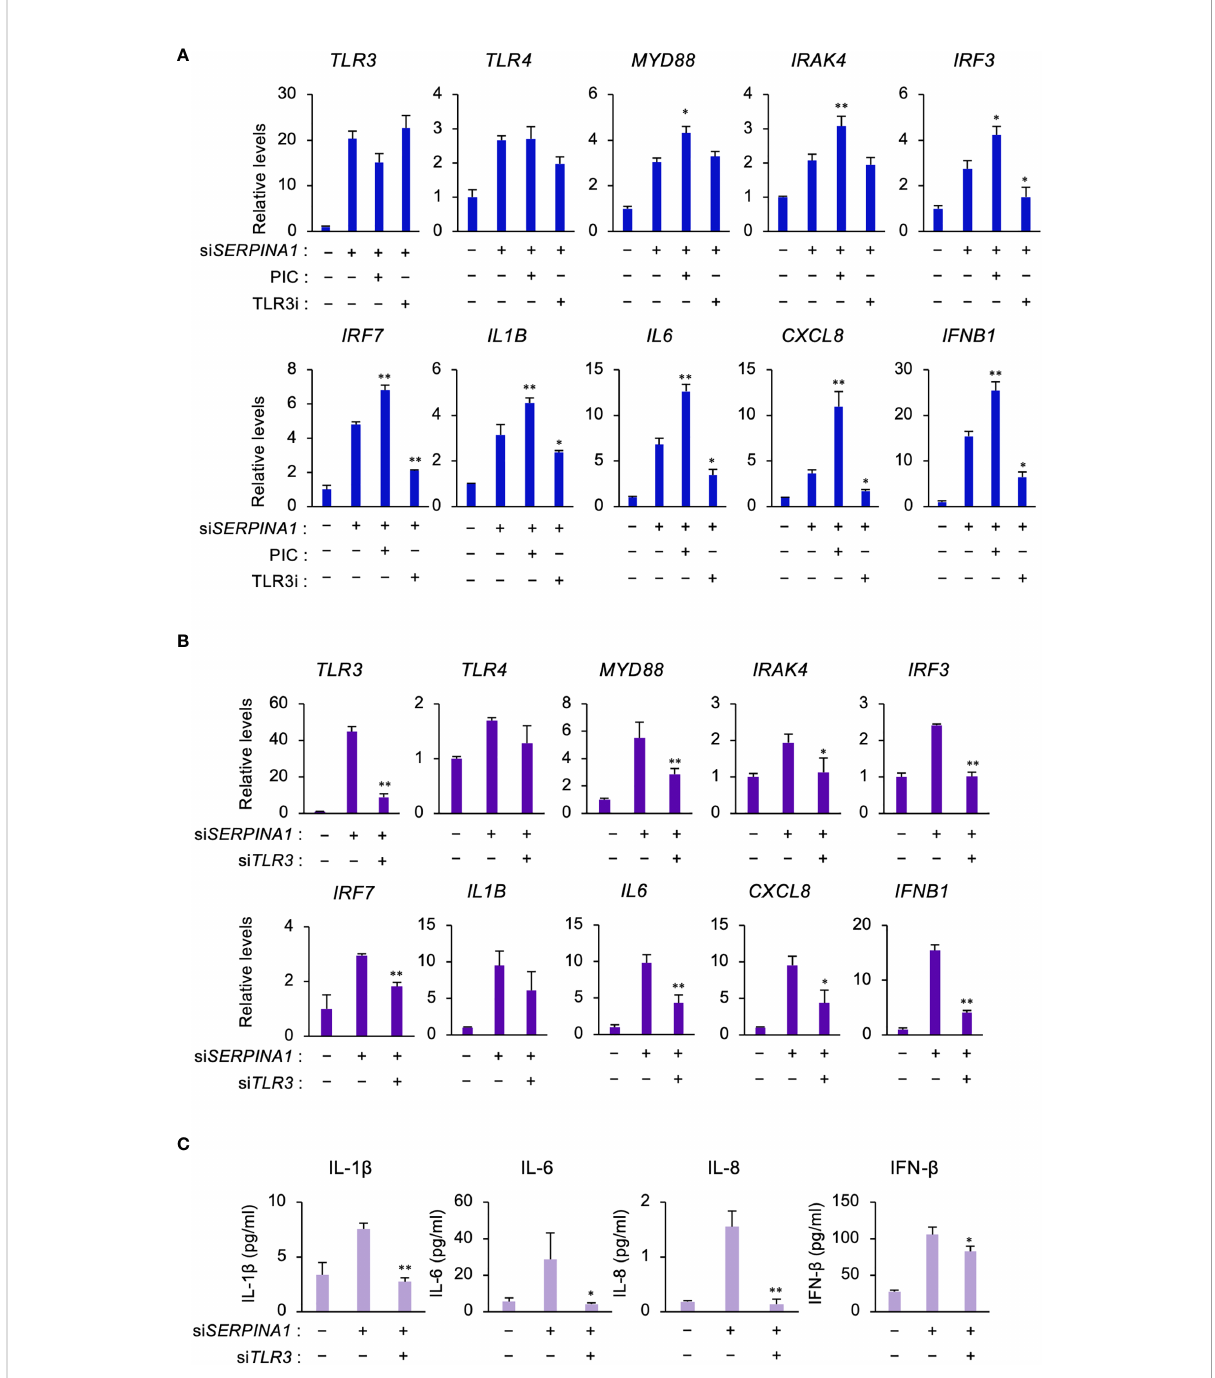
FIGURE 2 TLR3 upregulates expression of TLR- or in fl ammatory-related genes in ESCs. (A) Expression of TLR3 , TLR4, MYD88, IRAK4, IRF3, IRF7, IL1B, IL6 , CXCL8, and IFNB1 in primary ESCs pre-treated with PIC (10 m g/ml) or TLR3i (10 m M) and then transfected for 24 h with si SERPINA1 (n=3). GAPDH was used as the reference gene. Values represent the mean ± SEM of three independent experiments. * P <0.05, ** P <0.01 vs. si SERPINA alone. (B, C) Primary ESCs transfected for 24 h with si SERPINA1 and/or si TLR3 . (B) Expression of TLR3 , TLR4, MYD88, IRAK4, IRF3, IRF7, IL1B, IL6 , CXCL8, and IFNB1 in primary ESCs (n=3). GAPDH was used as the reference gene. Values represent the mean ± SEM of three independent experiments. * P <0.05, ** P <0.01 vs. si SERPINA alone. (C) The culture media were subjected to the ELISA to measure the concentration of IL-1 b , IL-6, IL-8, or IFN- b secreted from primary ESCs. Values represent the mean ± SEM of three independent experiments. * P <0.05, ** P <0.01 vs. si SERPINA1